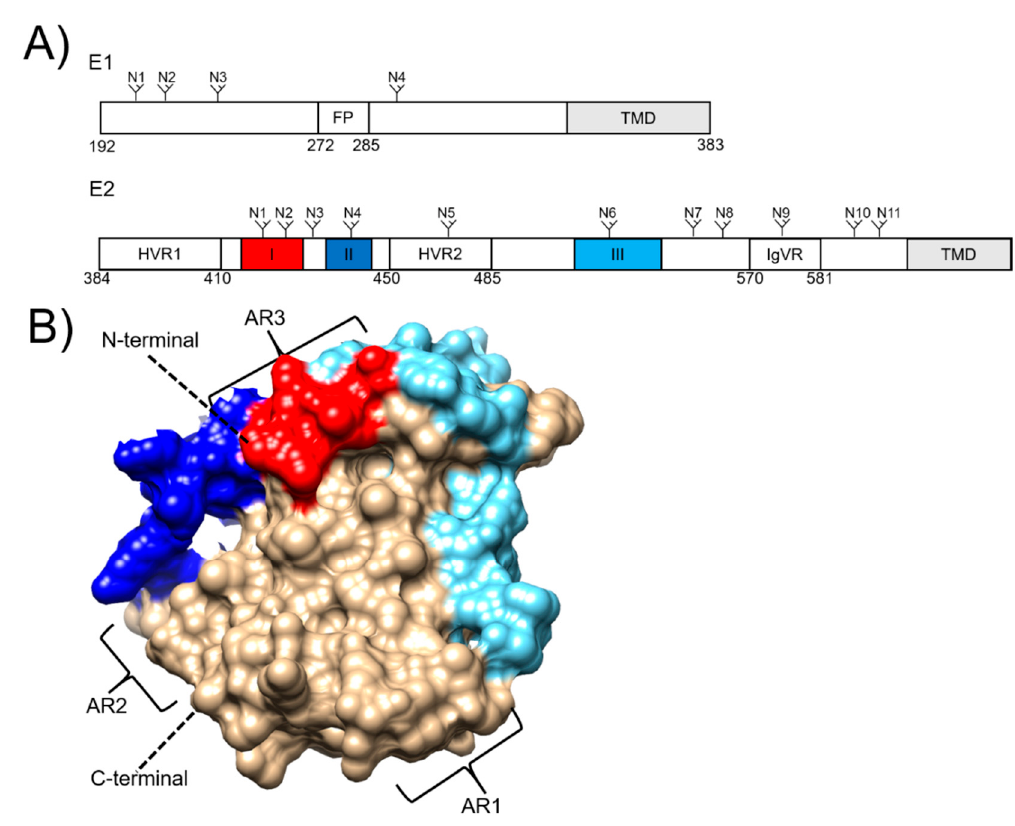
Figure 1. ( A ) Schematic diagrams of the hepatitis C virus envelope glycoproteins E1 and E2, showing N-linked glycosylation sites (N), transmembrane domains (TMDs), and the E1 fusion peptide (FP). E2 hypervariable regions (HVRs) 1 and 2, and the intergentypic variable region (IgVR) are also depicted. Linear epitopes I, II and III are highlighted in red, dark blue and light blue, respectively. ( B ) E2 structure (PDB: 6MEH). Linear epitopes I, II and III are highlighted in the corresponding schematic. Antigenic regions (ARs) are also shown.